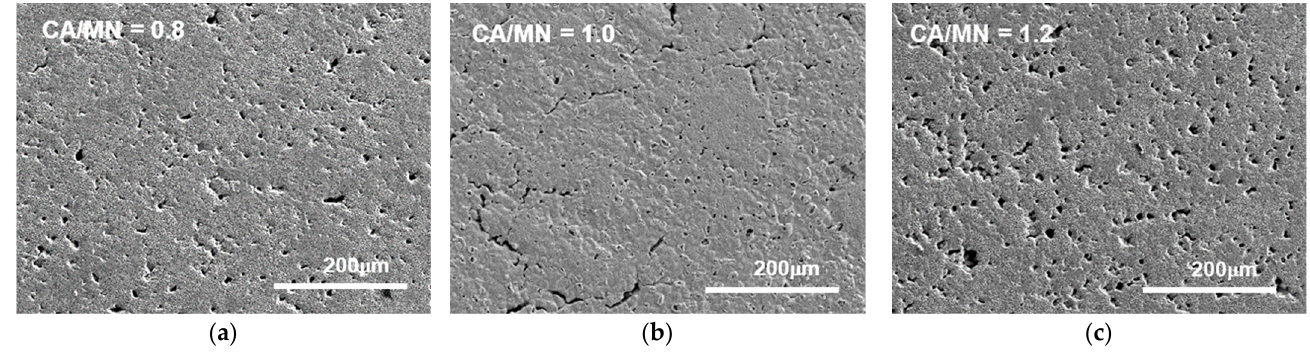
Figure 7. Microstructure of the pelletized CMC spinel sintered at 1200 °C using spinel powders synthesized at CA/MN ratios of ( a ) 0.8, ( b ) 1.0, and ( c ) 1.2.